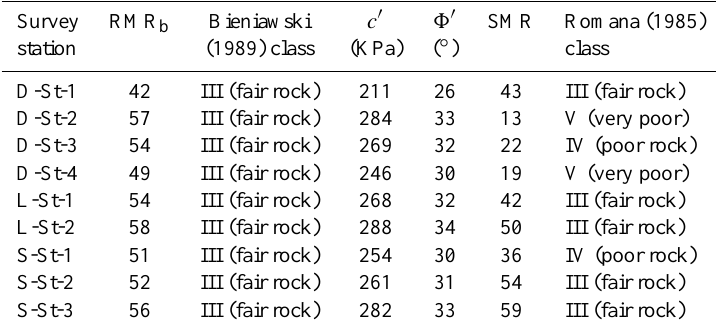
Table 2. Rock masse classification parameters.